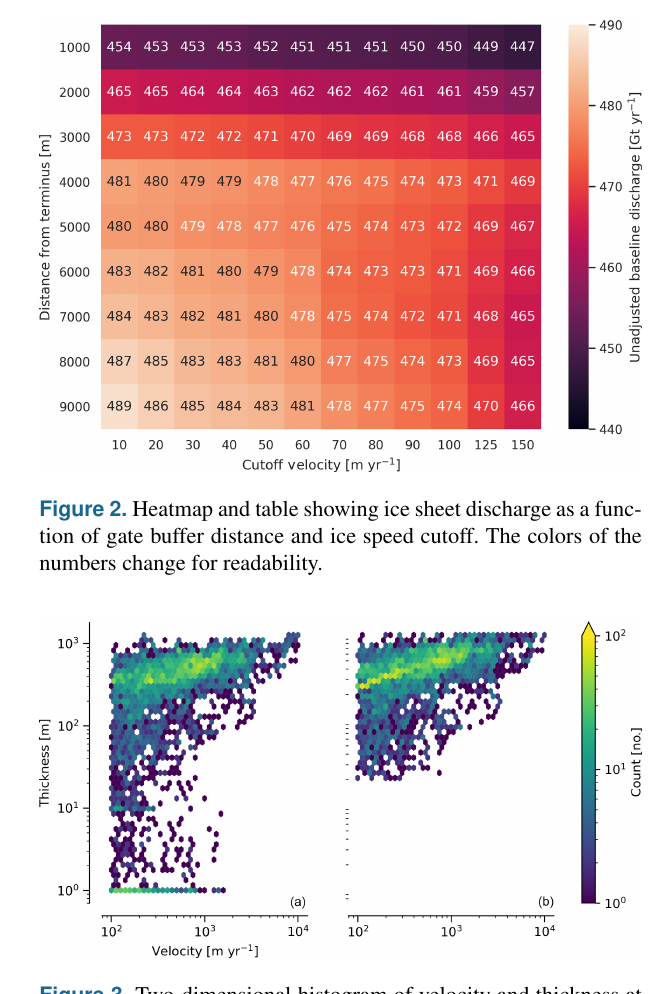
Figure 3. Two-dimensional histogram of velocity and thickness at all gate pixels. (a) Unadjusted (BedMachine and Millan et al., 2018) thickness. (b) Adjusted (as described in the text)